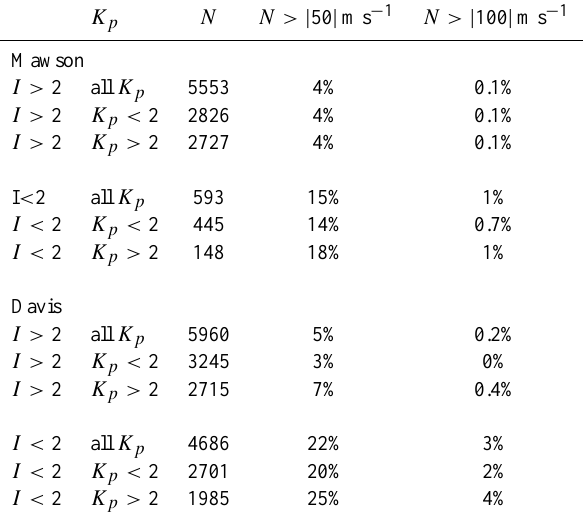
Table 4. Vertical winds selected by intensity and then K p , at both Mawson and Davis. The percentage of measurements > | 50 | ms − 1 and > | 100 | ms − 1 is also given K